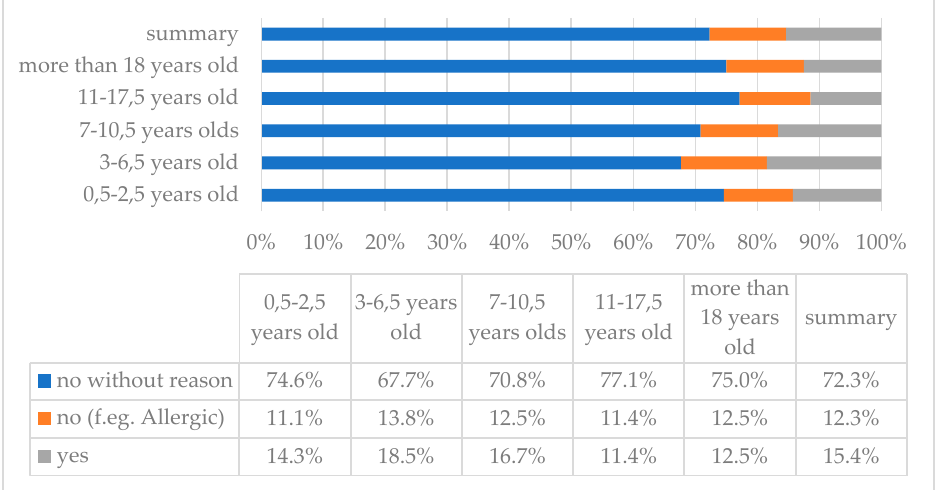
Figure 7. Nut consumption in the study group of people with DS by age.